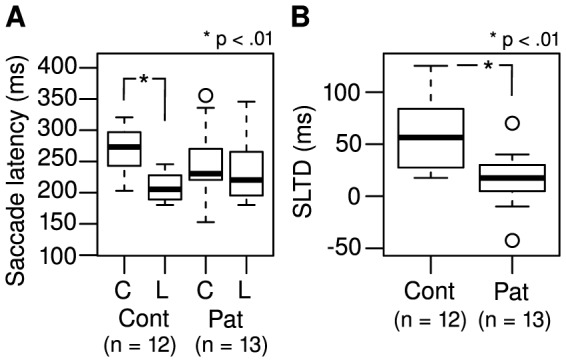
(A) Boxplots of saccade latency during the color (C) and Landolt (L) tasks.(B) Boxplots saccade latency task difference (SLTD) between controls (Cont) and patients (Pat).